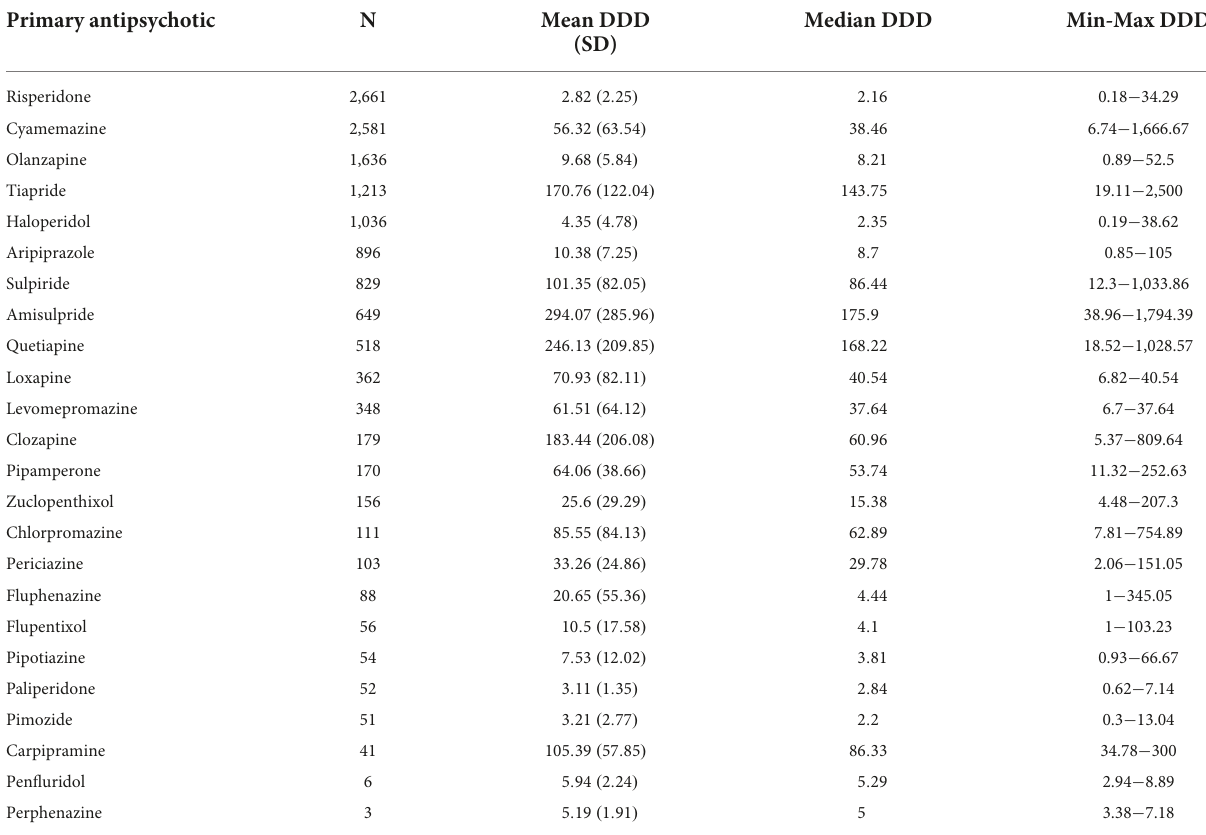
TABLE 3 Estimates of the daily dose dispensed (DDD) for the primary antipsychotic (in mg per day). Primary